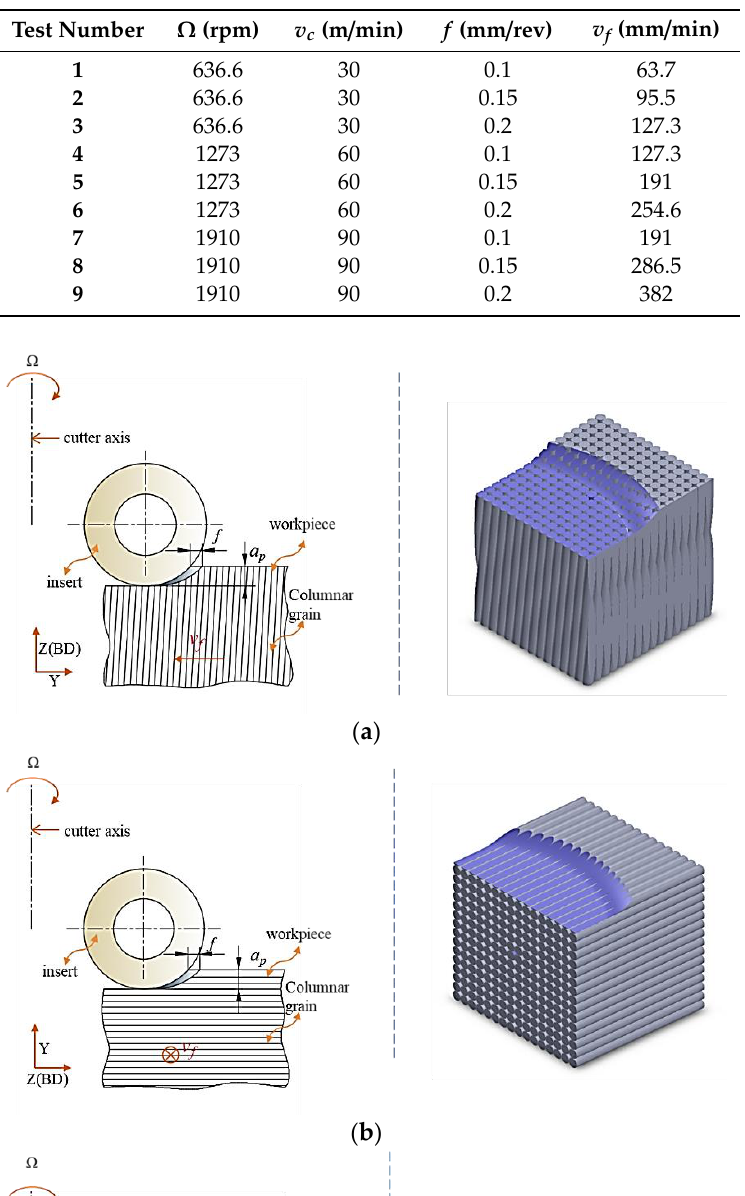
Table 1. Cutting parameters used in finish milling experiments.